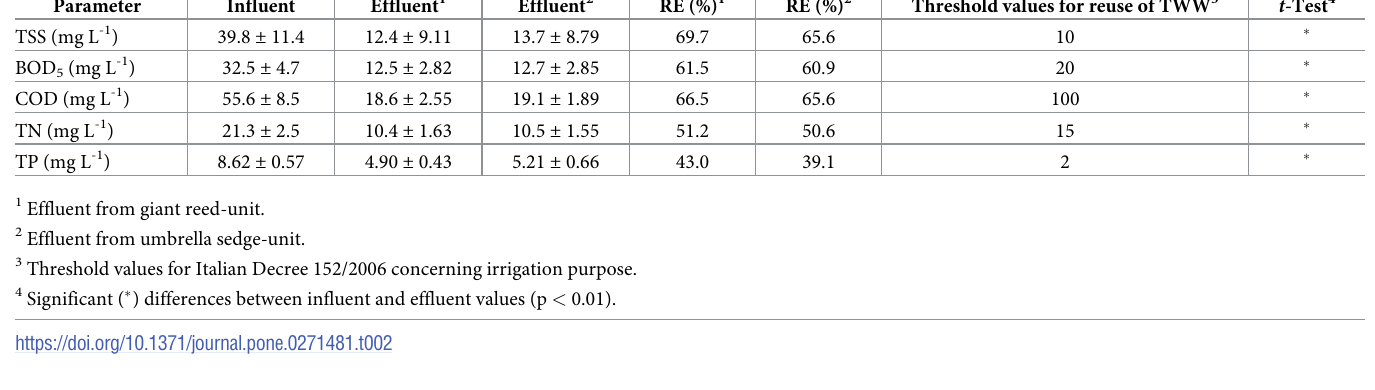
Table 2. Main chemical composition of the treated wastewater from inlet to outlet of the HSSFs CW. Removal efficiency (RE) from April to September 2016/2018. For each unit, three-year average values ( ± standard deviation) are shown (n = 36).